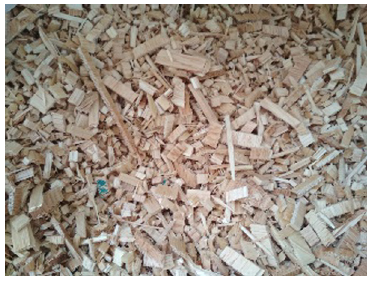
Figure 2: Particle from